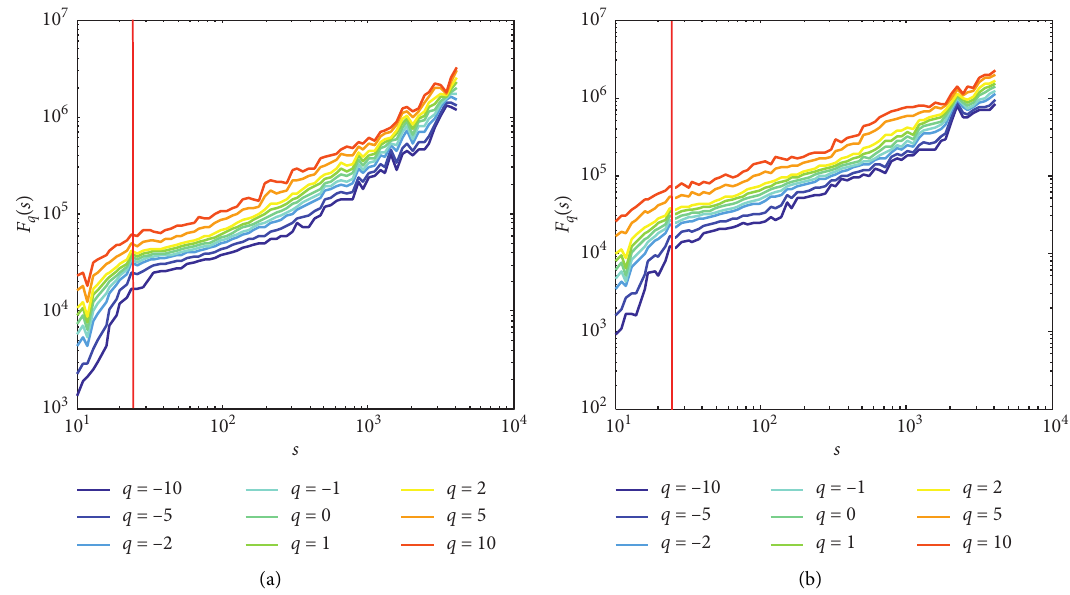
Figure 5: Relationships between F